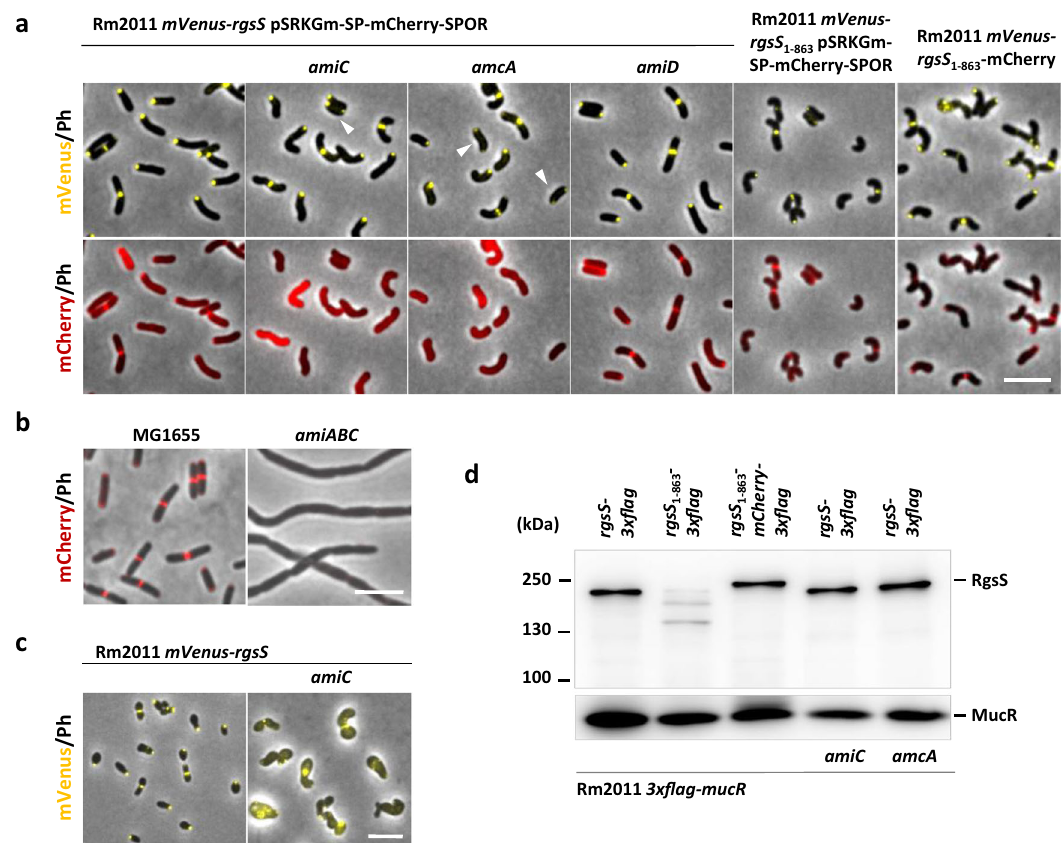
Fig. 1 Cell morphology and localization of mVenus-RgsS and mCherry-SPOR RgsS in strains, suf fi cient or de fi cient in AmiC, AmcA, or SPOR RgsS . a Fluorescence microscopy images of exponentially growing TY cultures of indicated S. meliloti strains. White arrowheads indicate cells with bipolar mVenus-RgsS localization. Scale bar, 5 µ m; Ph, phase contrast. The images are representative of two independent cultivations and microscopy analyses. b Fluorescence microscopy images of cells from M9 cultures of indicated E. coli strains, carrying pSRKGm-SP-mCherry-SPOR. Scale bar, 5 µ m; Ph phase contrast. The images are representative of two independent cultivations and microscopy analyses. c Fluorescence microscopy images of cells from exponential phase LB cultures of S. meliloti Rm2011 mVenus-rgsS and its amiC -de fi cient derivative. Scale bar, 5 µ m; Ph phase contrast. The images are representative of three independent cultivations and microscopy analyses. d Western blot analysis with α -FLAG antibody of Rm2011 3x fl ag-mucR strain, expressing genes encoding C-terminal 3XFLAG tag-RgsS fusions from the rgsS promoter at the native genomic location. Strains were grown in TY supplemented with gentamicin. 3×FLAG-MucR produced from 3x fl ag-mucR at the native genomic location was used as a loading control. The result is representative of three biological